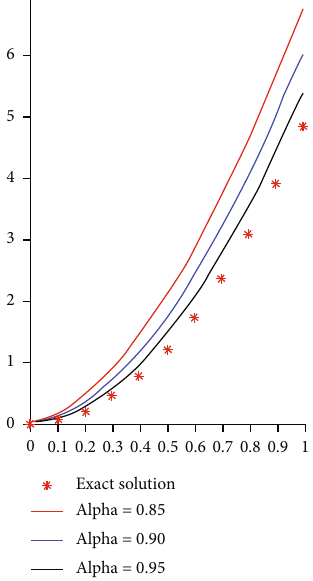
Figure 4: The solutions ψ ð x , t Þ = φ ð x , t Þ for equation (68) at di ff erent values of α and β